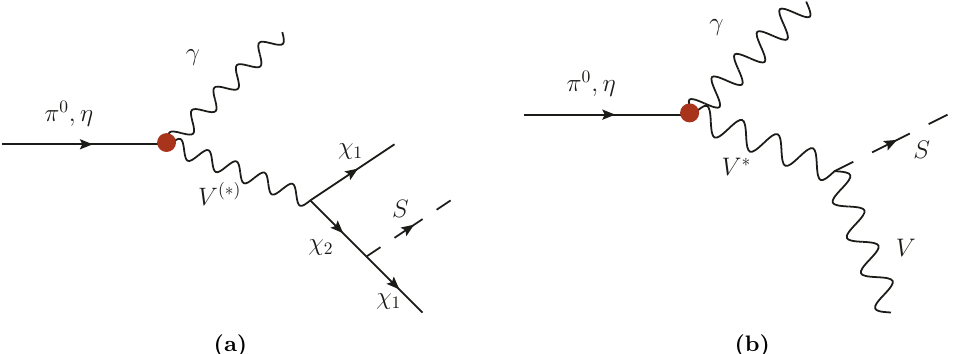
Figure 4. Dark Higgs boson production in meson decay through (a) chain decay of a heavy dark sector state and (b) dark